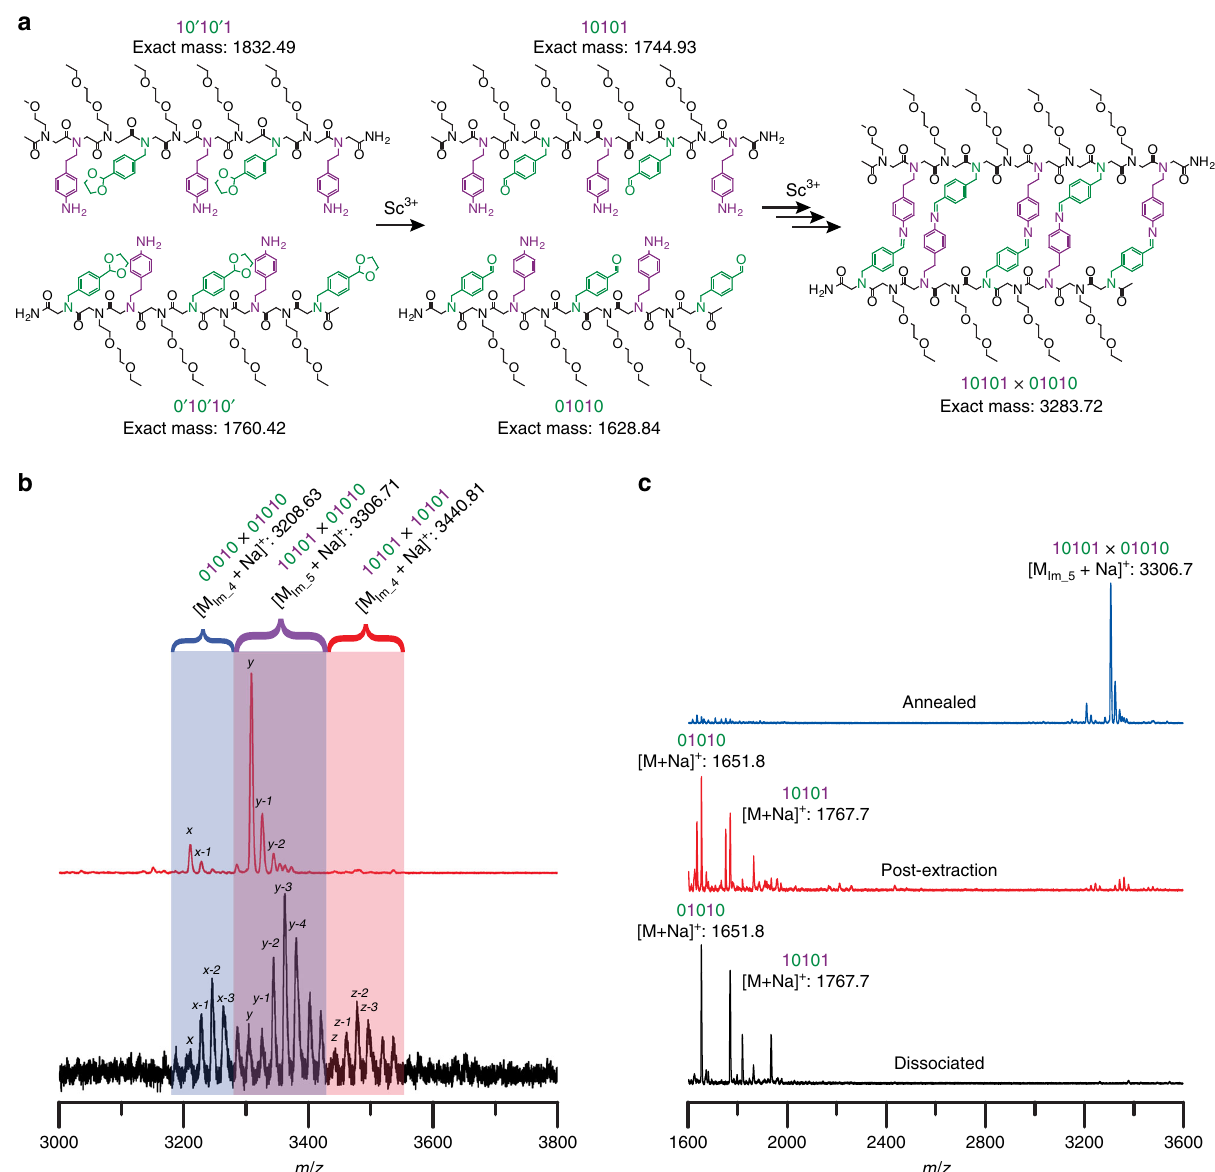
Fig. 1 Dynamic covalent assembly of encoded molecular ladders. a Structures of complementary, mass-labeled precursor peptoids and desired, in-registry molecular ladder product. b MALDI mass spectra of molecular ladder reaction mixtures generated either after a single-step, deprotection, and direct assembly process (bottom, black), or via a stepwise, dissociation/extraction/annealing assembly process (top, red). Peaks at multiples of + 18 m / z values are attributable to ladders species with fewer rungs (e.g., y = in-registry, 5-rung 10101×01010 molecular ladder, y − 1 = out-of-registry, 4-rung 10101×01010 molecular ladder, etc.). c MALDI mass spectra of the reaction mixture initially containing 10101 and 01010 sequences and a high loading of Sc(OTf) 3 (bottom, black), immediately after aqueous extraction (middle, red), and after annealing at 70°C for 2h (top, blue). Expected exact masses: [M 01010 + Na] + =